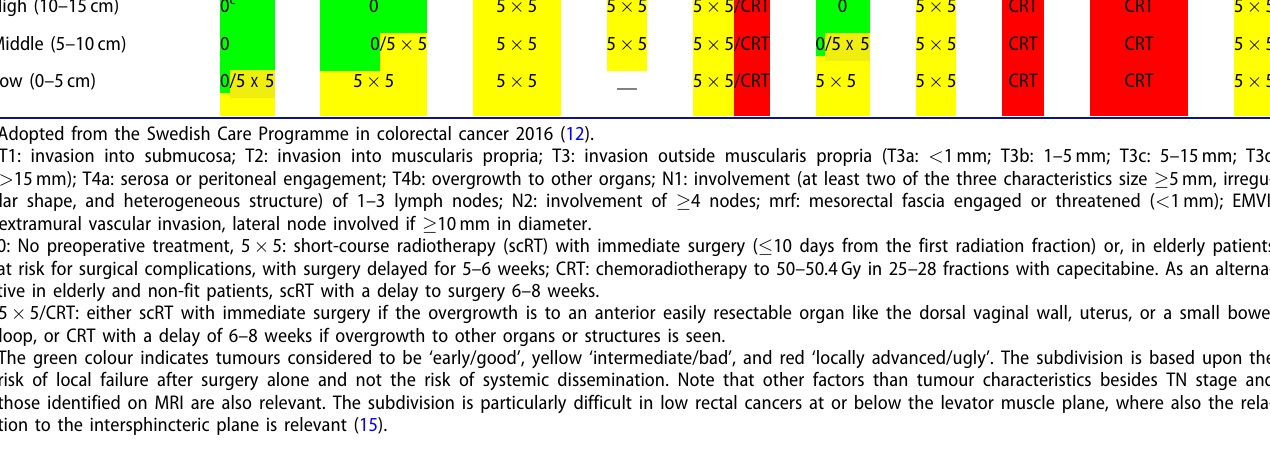
Tumour characteristics